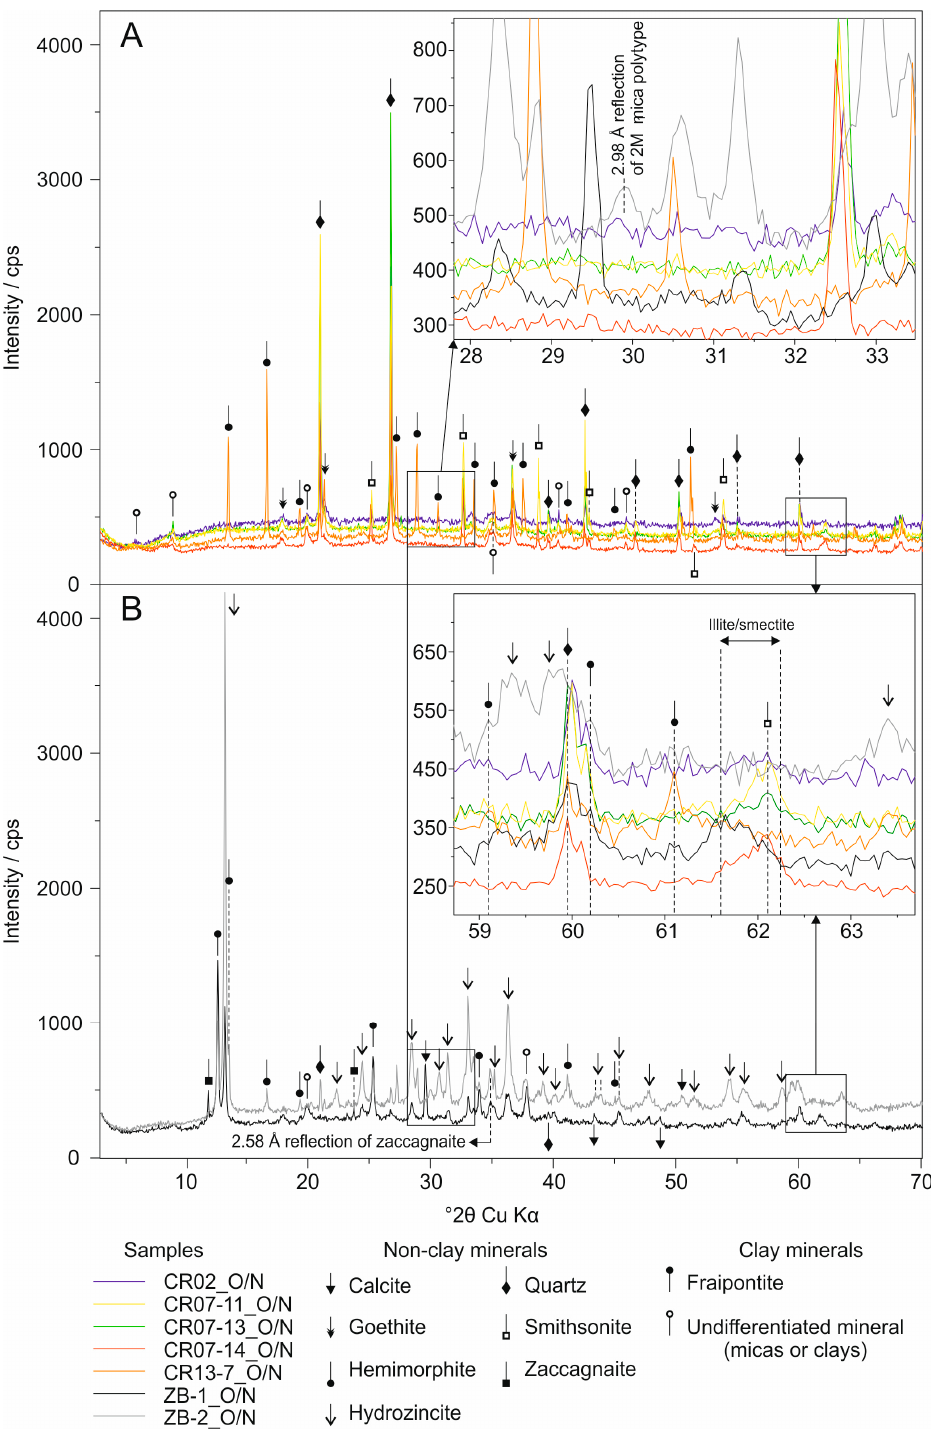
Figure 3. X-ray powder diffraction (XRPD) patterns of randomly oriented (O/N) residues of Cristal ( A ) and Mina Grande ( B ) samples, which show the main reflections of the detected minerals, those corresponding to the 060 spacings and the diagnostic 2.98 Å peak of the 2M 1 mica polytype.